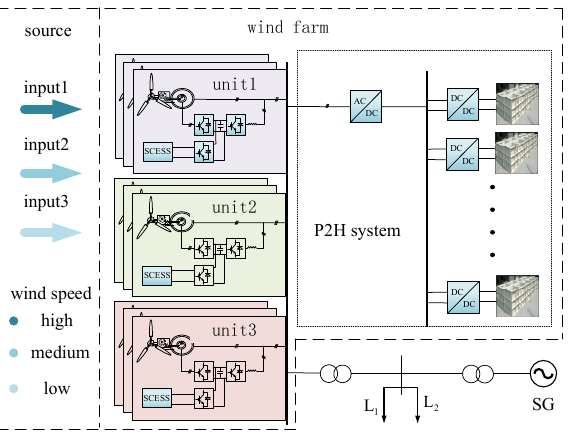
Figure 11. Simulation model of a SCESS-DFIG-P2H generating station. As shown in Figure 11, the three units in the wind farm were connected to the 17 MW P2H system consisting of 10 groups of 1.7 MW P2H modules through the AC bus at different wind speeds. The wind farm was connected to the loads L 1 , L 2 and the synchronous generator SG through a step-up transformer. Among them, the rated power of the synchronous generator was 100 MW, equipped with an excitation regulator and governor, the L 1 was a fixed load of 30 MW, and the L 2 was a sudden load that caused the system frequency to drop. The simulation parameters of the wind turbine and synchronous generator are shown in Appendix B (Table A1). When the wind speed was 7 m/s, the output power of the DFIG was 0.53 MW, and the wind turbine did not meet the grid-connected power generation conditions. When the wind speed was 12 m/s, the output power of the DFIG was rated 2.5 MW, and the output power of the fan did not change with the increase in the wind speed. As a result, by comparing the output power of the DFIG, this paper defines the low wind speed as 8 m/s, the medium wind speed as 10 m/s, and the high wind speed as 12 m/s. The three groups of SCESS-DFIGs were all set to work at a medium wind speed with a wind speed of 10 m/s. The proposed control strategy was adopted, and the system frequency regulation curve, P2H and SCESS operation state are shown in Figures 12–14 with different time constants of the delay link.